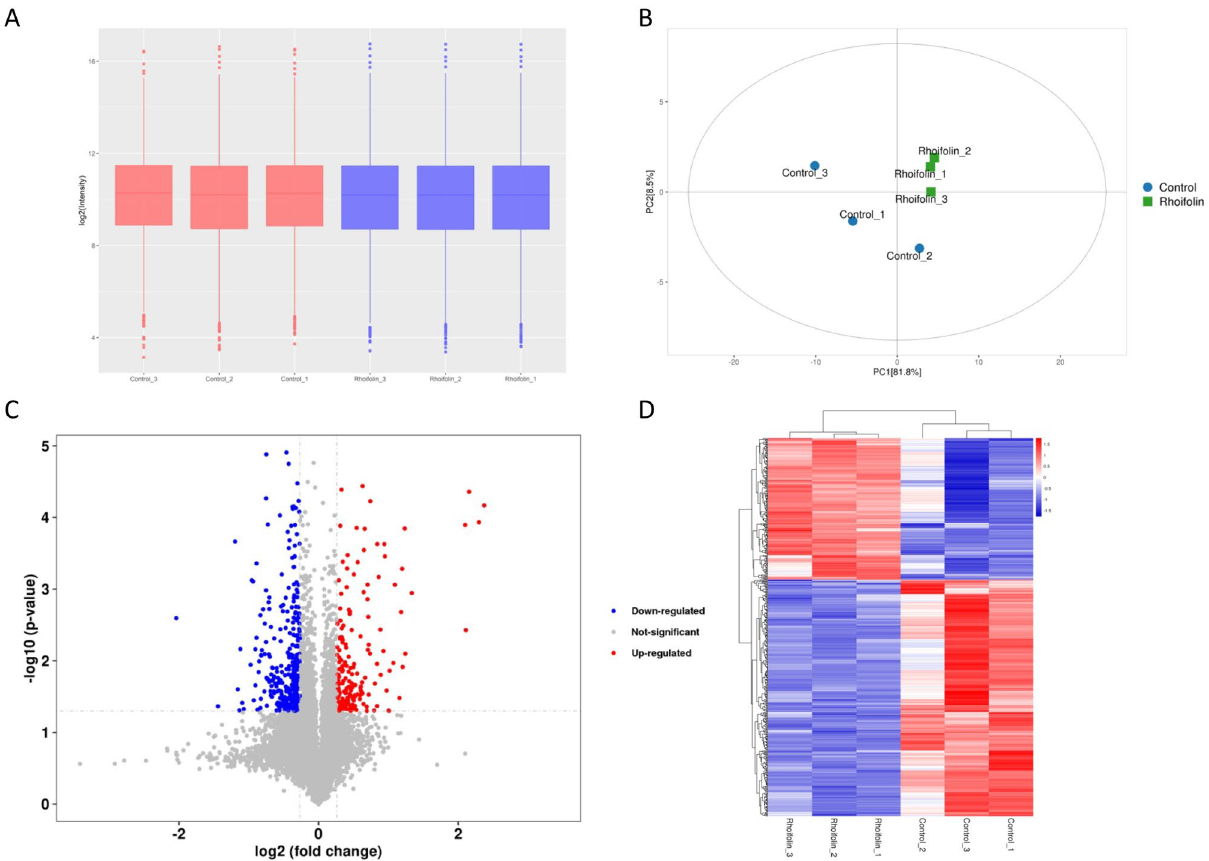
Figure 7. Identification of DEPs by rhoifolin treatment. ( A ) The box plot of log2 of the protein intensity in each sample. ( B ) The principal component analysis (PCA) of all 6 samples. ( C ) The volcano plots of 522 DEPs, Thresholds:fold change > 1.2 or < 0.83; Student’s t-test: p value < 0.05. ( D ) The heatmap of hierarchical clustering analysis of 522 DEPs. Rows represent proteins, and columns represent